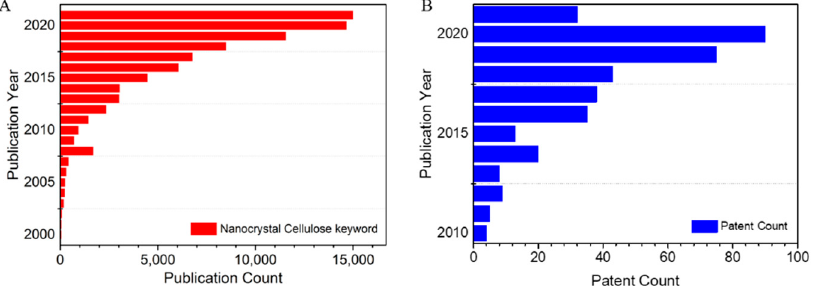
Figure 1. ( A ) Publications (journal articles and book/book chapters) and ( B ) Patent (filed and granted) documents related to nanocrystal cellulose.